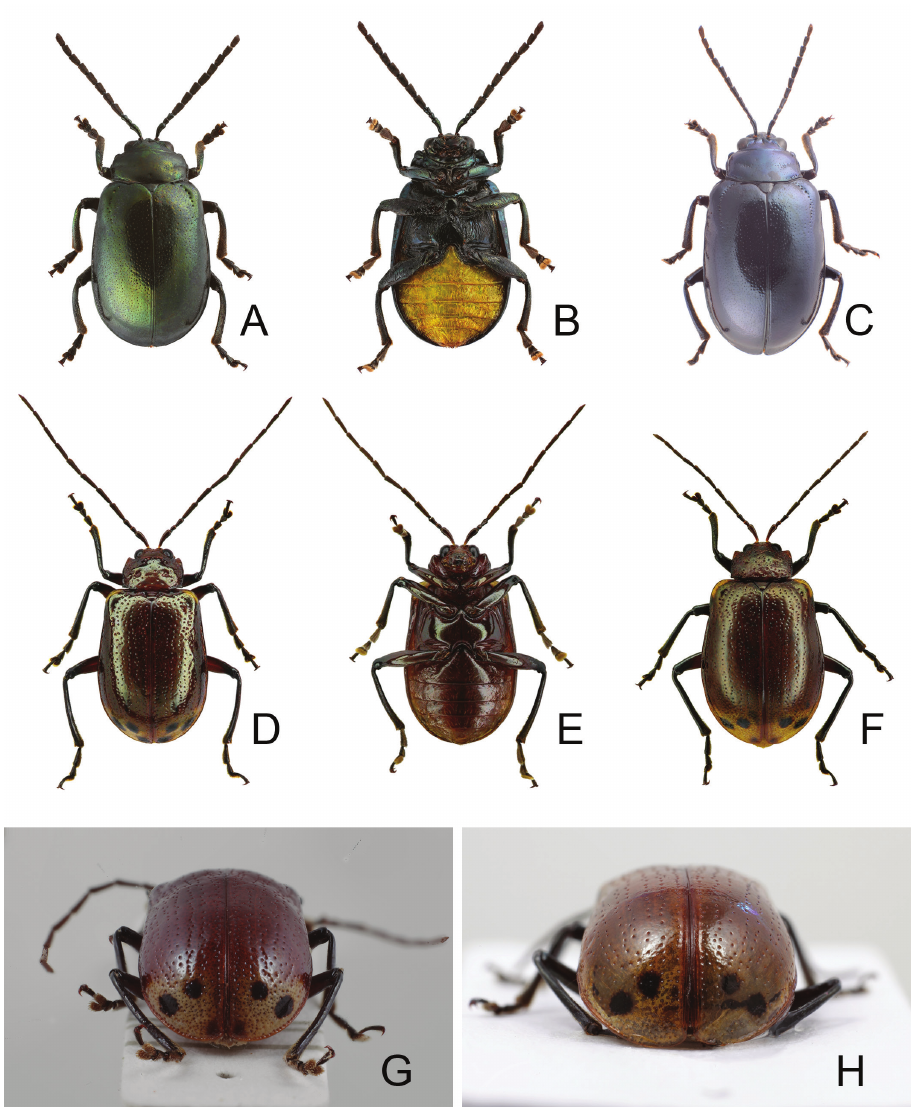
Figures 4. Habitus of Gallerucida species. A G. flaviventris (Baly), male from Taiwan, dorsal view B Dit- to, ventral view C G. flaviventris (Baly), female from China, dorsal view D G. singularis Harold, male, dorsal view E Ditto, ventral view F G. singularis Harold, female, dorsal view G G. singularis Harold, posterior view H G. gebieni Weise, posterior